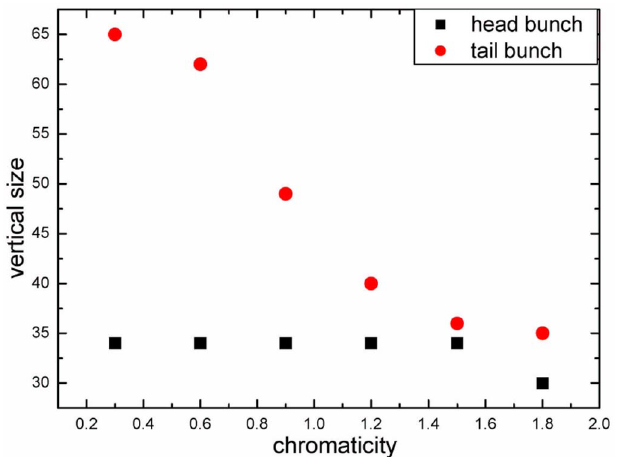
FIG. 27. (Color) Vertical beam size of the first and last bunch in a train as a function of chromaticity at BEPC in 2004 [38]; the beam size was measured by a streak camera.